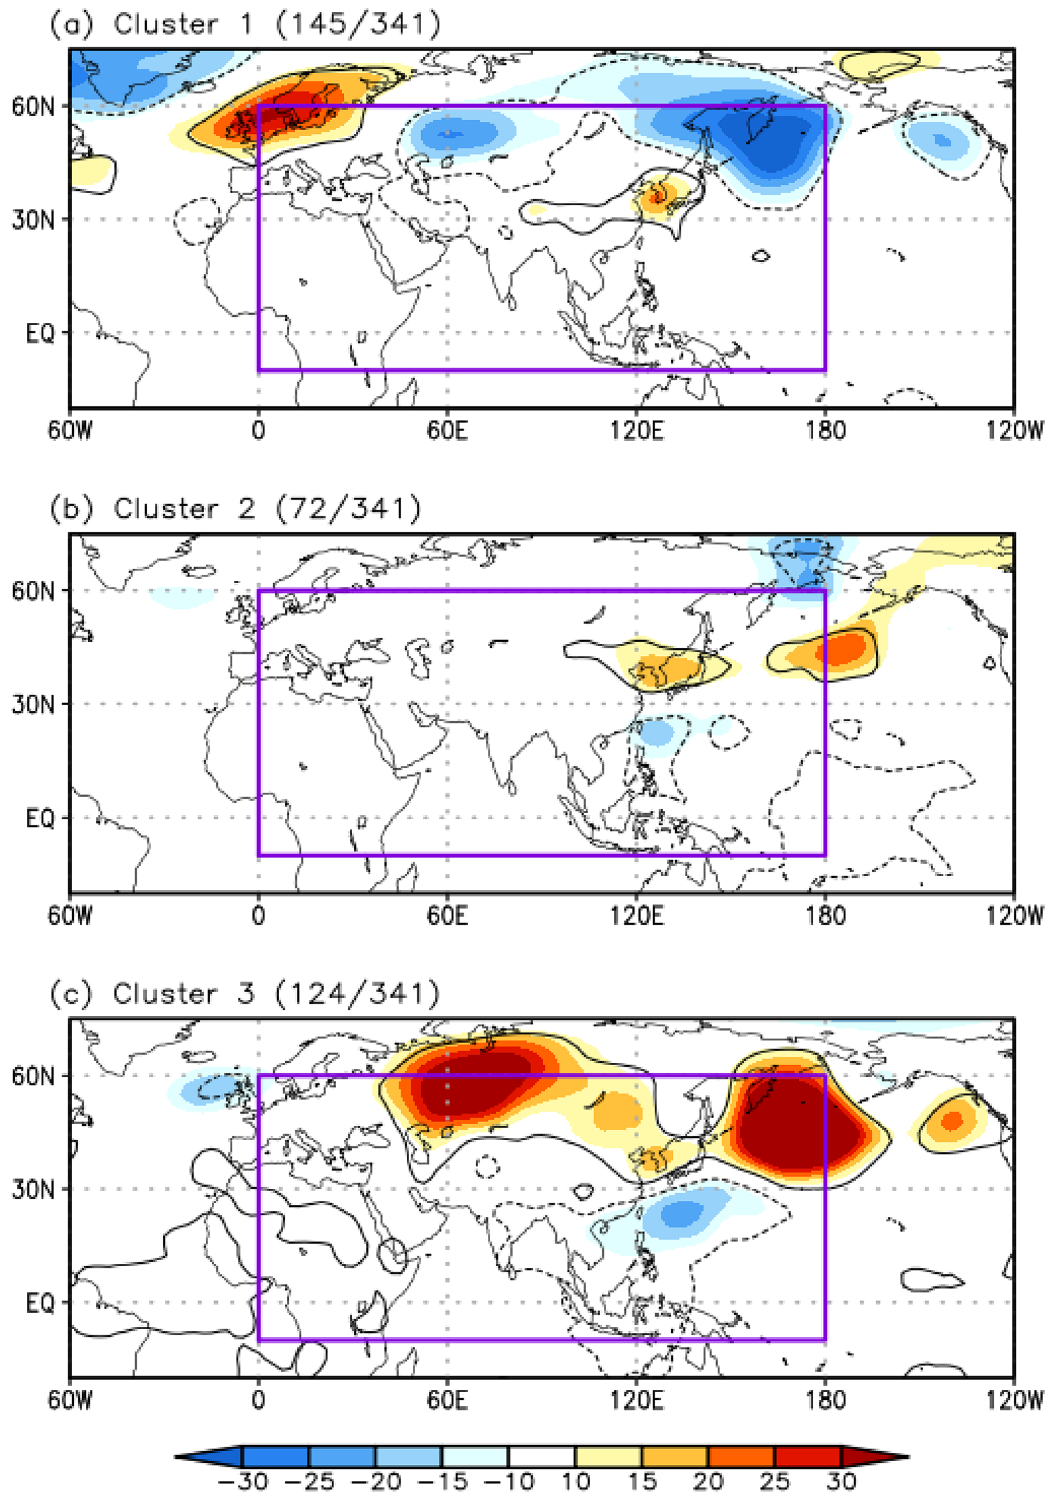
Figure 2. Composite maps of the 850-hPa GPH (shaded; m) anomalies for the three SOM cluster patterns. The purple box (i.e., 0°–180° E and 10° S–60° N) denotes the region of the input vector for the SOM. Contours represent statistically significant areas satisfying the 99% confidence level based on the Student’s t -test. The number of EHDs in each cluster are shown in parentheses. Maps were generated using GrADS version 2.1.a1 (http:// cola. gmu. edu/ grads/ downl oads.